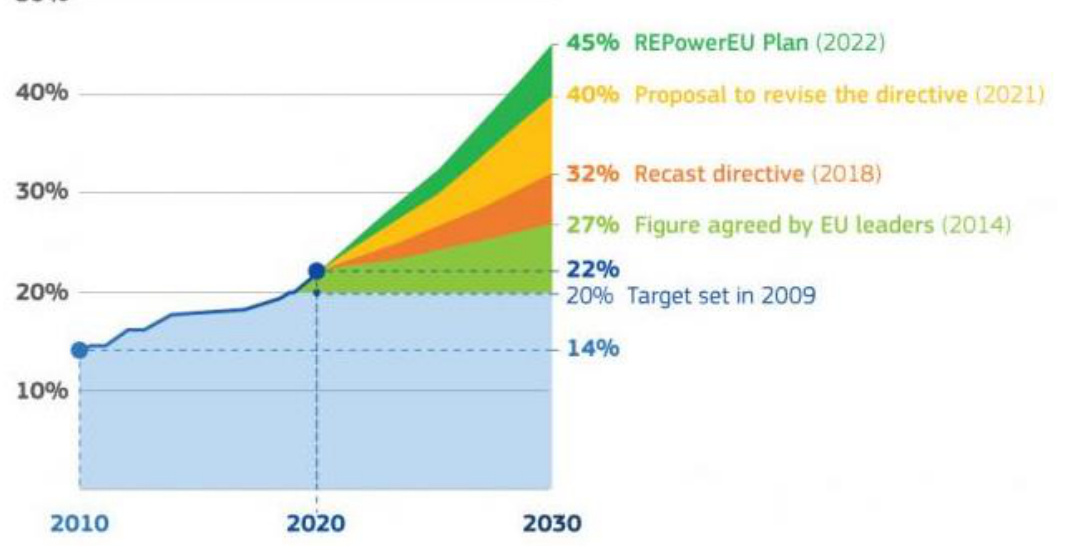
Figure 3. Evolution of renewable energy targets in European Union [50].